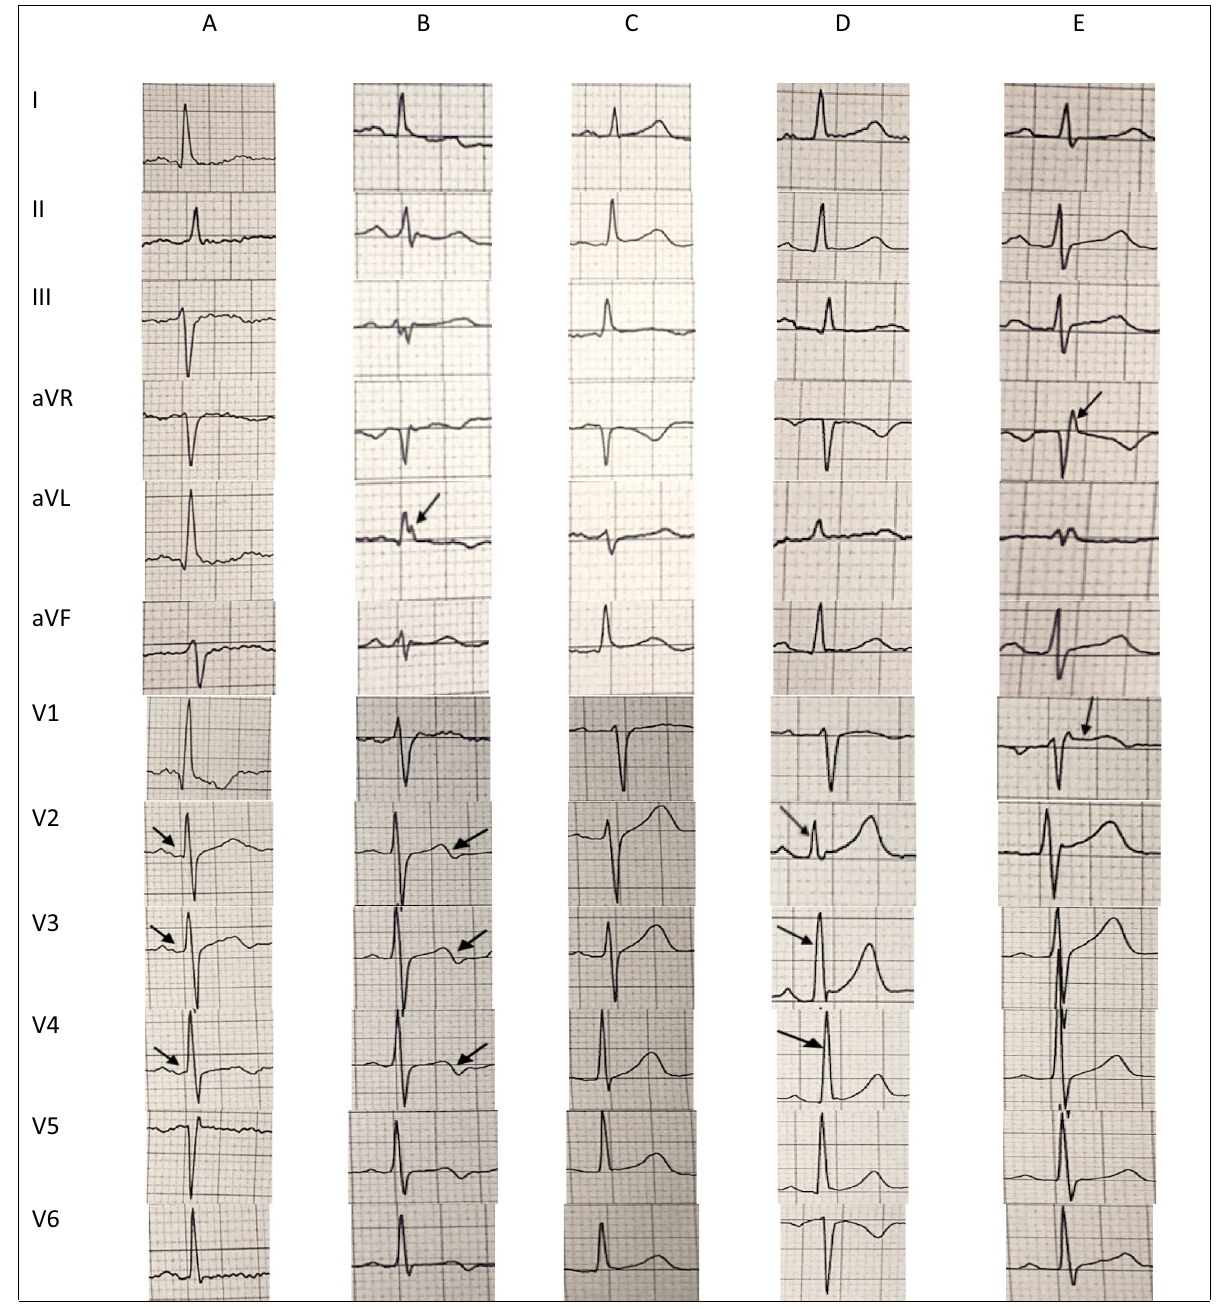
Figure 2. Baseline ECG characteristics of some the persons with short QT interval. ( A ) [case #1] a 52 Y/O male with a score 3 QTc, bradycardia (HR: 49) and AF. PQ segment depression is noted; ( B ) [case #2] a 43 Y/O male with a score 3 QTc. A notch in aVL lead in favor of scarring and a biphasic T wave are noted; ( C ) [case #17] a 46 Y/O male with a score 1 QTc, bradycardia (HR: 50), low voltage ECG and syncope; ( D ) [case #59] a 53 Y/O male with a score 1 QTc, relative bradycardia (HR: 59), AF, and counter clockwise rotation who expired due to SCD during the cohort; ( E ) [case #64] a 54 Y/O male with a score 1 QTc and relative bradycardia who was suspicious to the type II Brugada syndrome (a saddleback ST segment elevation in lead V1 and a prominent R wave in lead aVR, but not fulfilled R wave sign). Brugada test was not